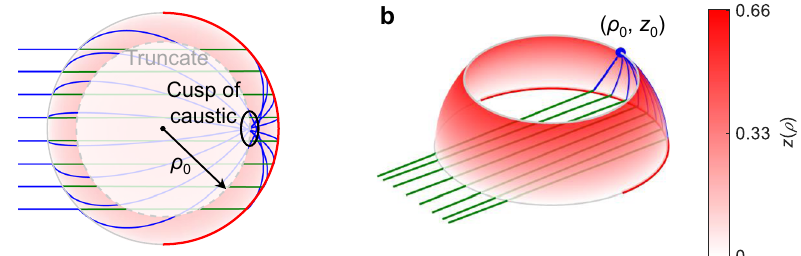
Fig. 5 Truncation of lens. a Ray trajectories and caustic (top view), b truncated double-layer `invisible' lens. The present example is with the dimensional parameters ρ 0 = 0.75 and z 0 ≈ 0.66.